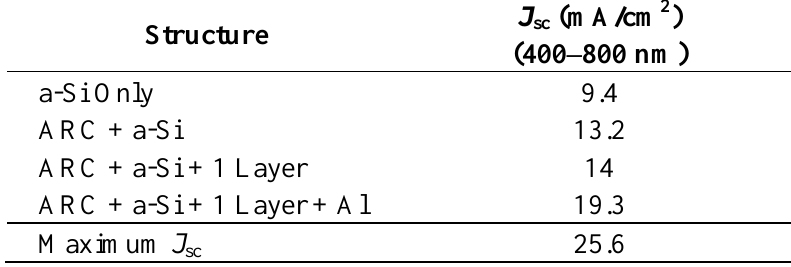
Table 6. Short circuit current characteristics ( J considered in this study.